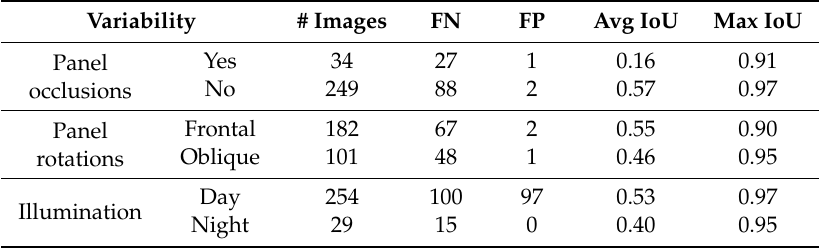
Table 7. Specific results for SSD with respect to occlusions, rotations and illumination.